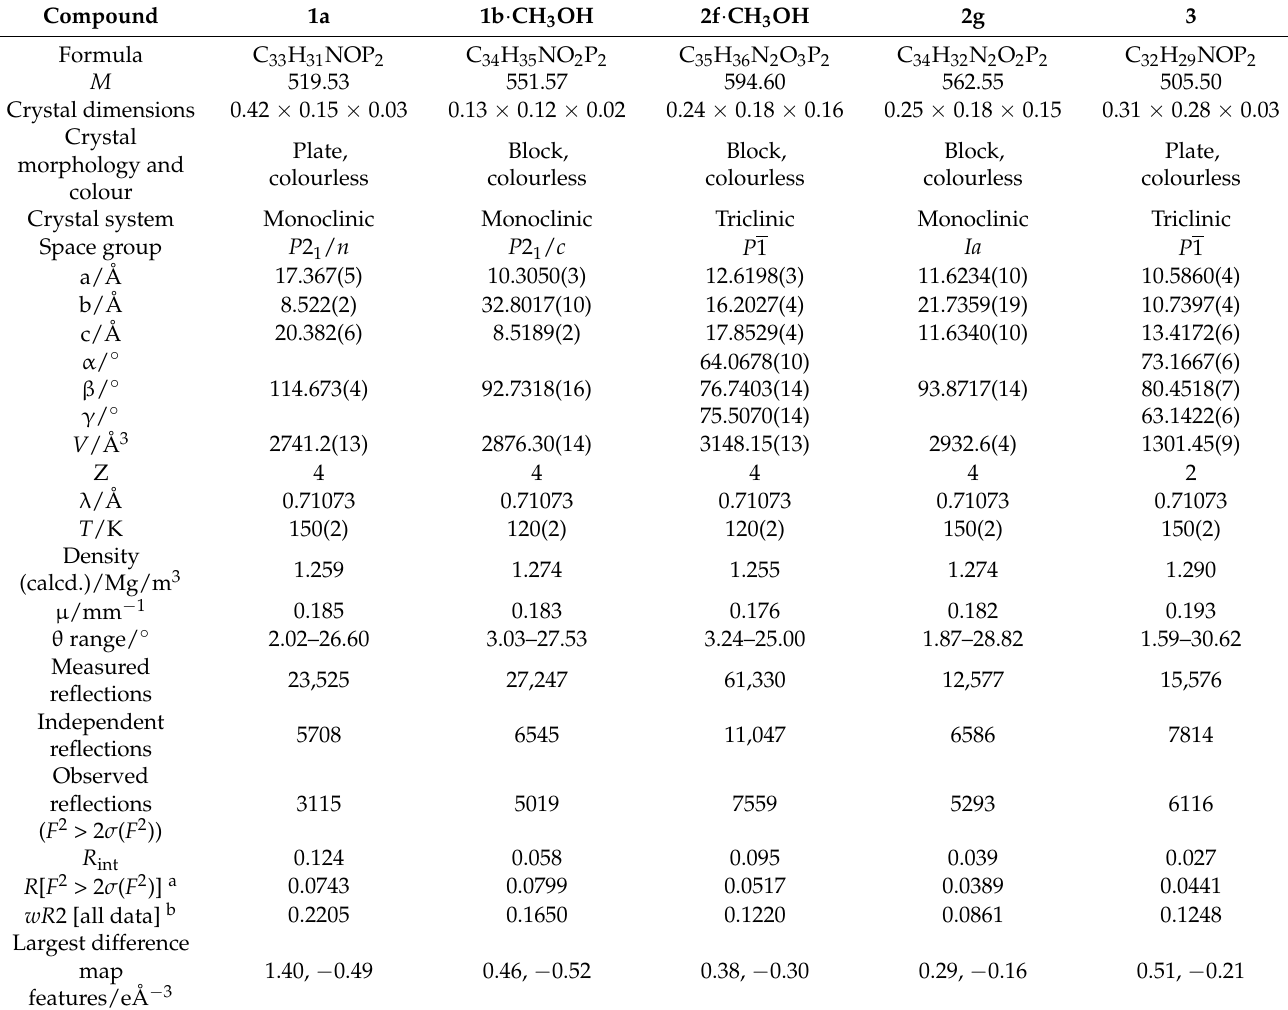
Table 2. Details of the X-ray data collections and refinements for compounds 1a , 1b · CH 3 OH, 2f · CH 3 OH, 2g , and 3